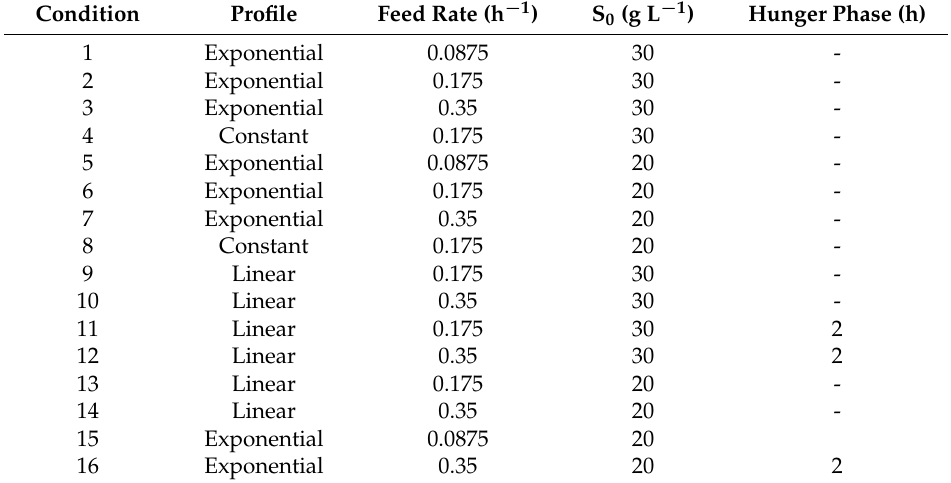
Table 1. Cultivation details. The experimental conditions regarding each mini-bioreactor are shown, including the fed-batch profile, feed rate, initial substrate concentration S 0 and occurrence of a hunger